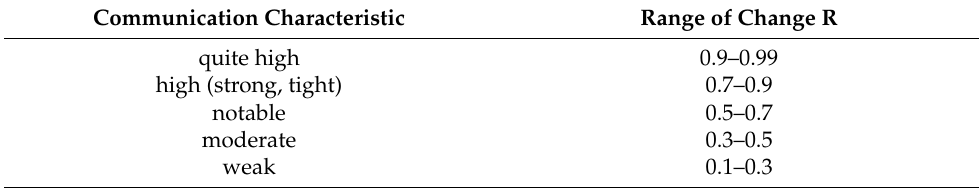
Table 2. Value scale for determining the bond density in stochastic